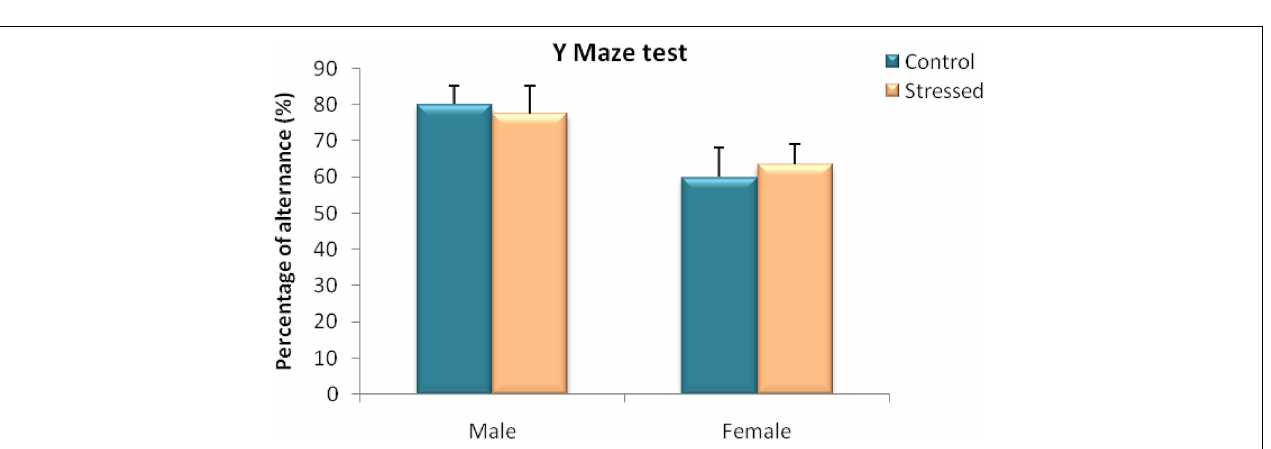
FIGURE 4 | Variation in food intake in control and stressed rats of both sexes. Male rats are not affected by chronic intermittent cold stress until the 14th day (post stress), represented by a decrease in food intake (A) . In female rats, cold exposure leads to a significant decrease in food intake (B) . Food intake is expressed in grams (g). Data are represented as mean ± SEM ( n = 5). (A) Male rats: Effect of stress: ns p > 0.05. Effect of the day: ** P < 0.01. ( n = 5). (B) Female rats: Effect of stress: * p < 0.05. Effect of the day: ns p > 0.05 (ns: not significant).